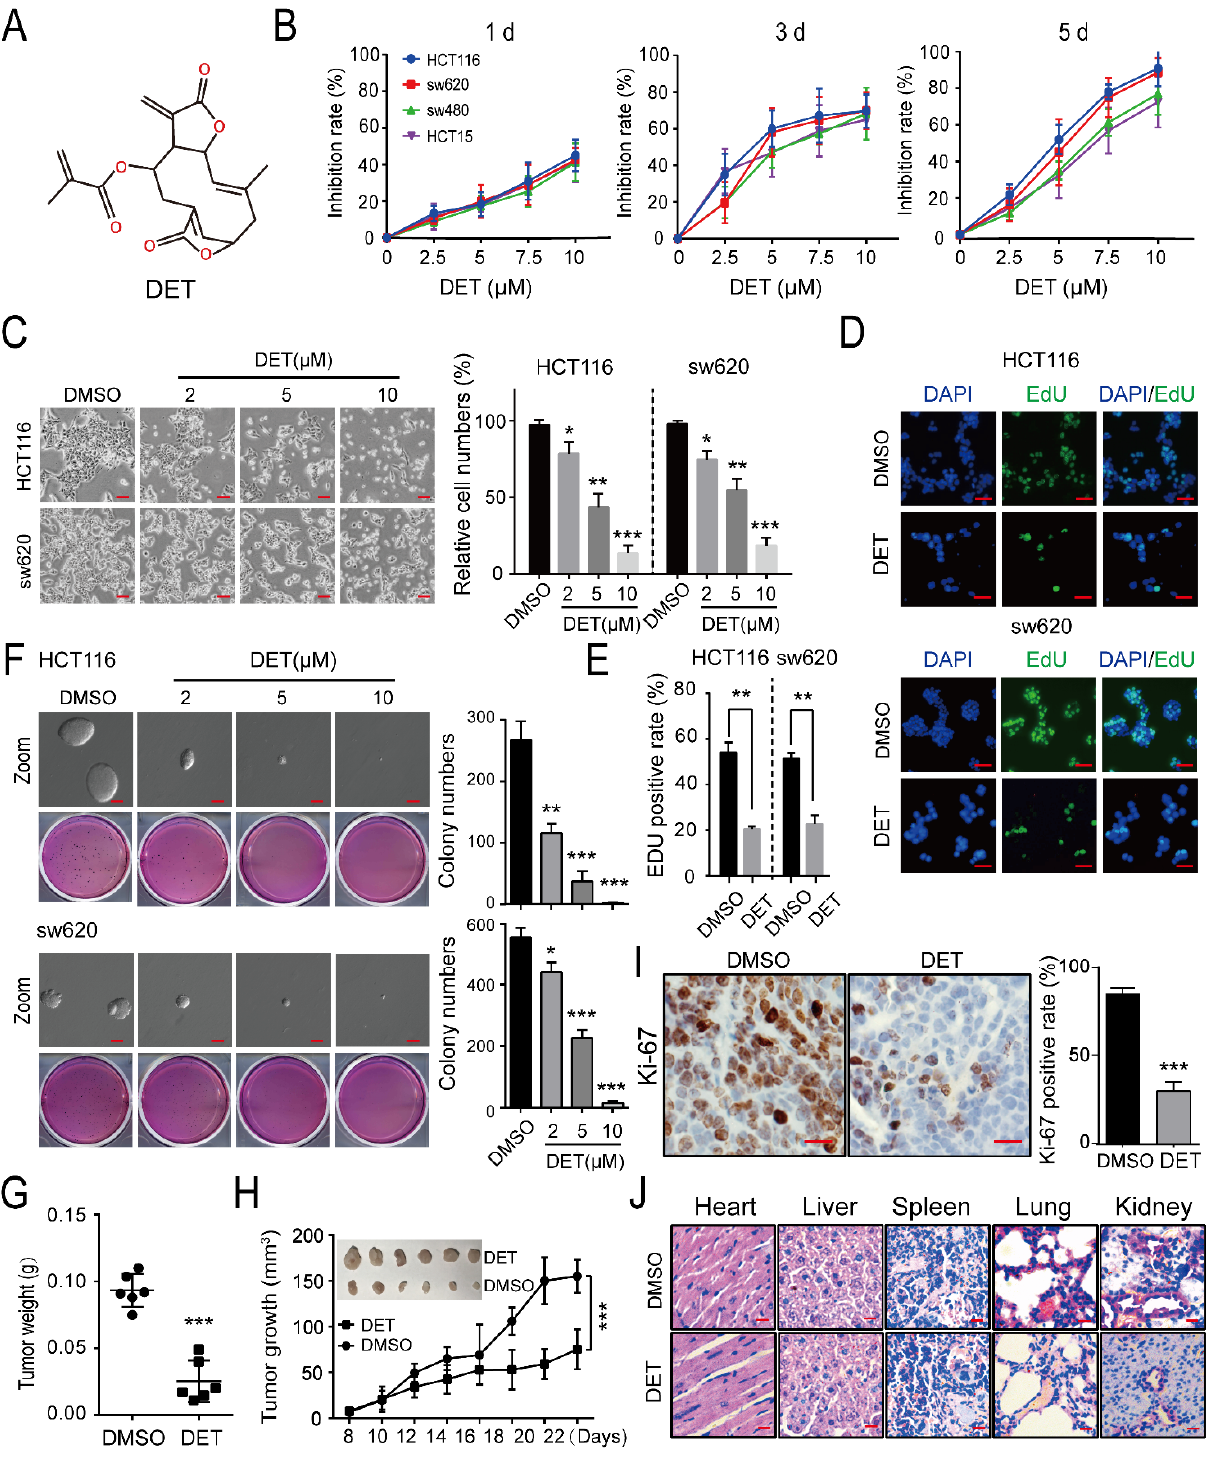
Figure 1. Deoxyelephantopin (DET) inhibits colon cancer without obvious organ toxicity. ( A ) The chemical structure of DET. ( B ) Graphic representation of results from MTT assays to determine cell inhibition rate of HCT116, sw620, sw480, and HCT15 cells. ( C ) Morphology of HCT116 and sw620 cells after treatment with DMSO or different concentrations of DET for 48 h. Scale bar = 20 µm. ( D ) Fluorescence images of EdU incorporation in HCT116 and sw620 cells treated with DET or DMSO for 48 h. Cells were stained to detect EdU (green) and DAPI (blue) to highlight nuclei, and images were superimposed. Scale bars = 20 µ m. ( E ) The percentage of EdU+ cells (EdU+/DAPI+ ×